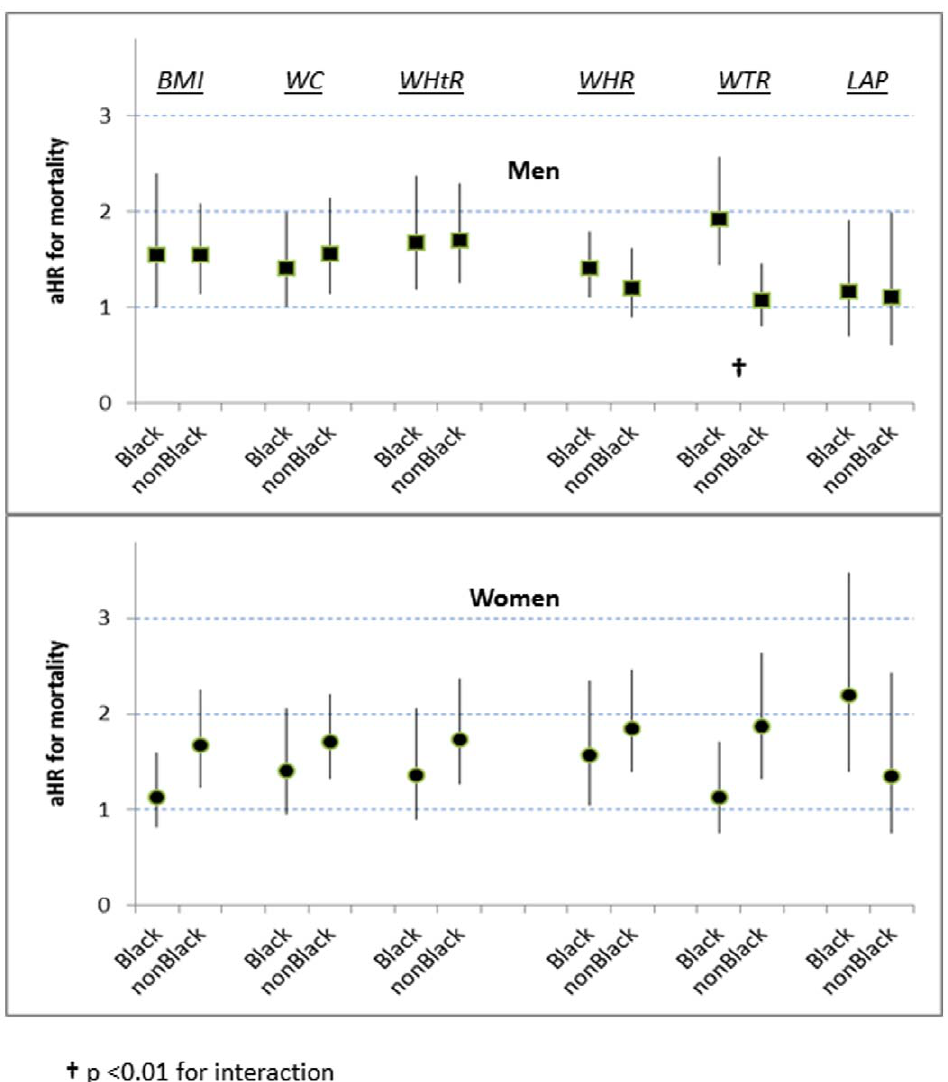
Figure 2. Interactions with ancestral group for mortality risk at p75, by 6 adiposity indicators. (aHR=multiply adjusted hazard ratio).